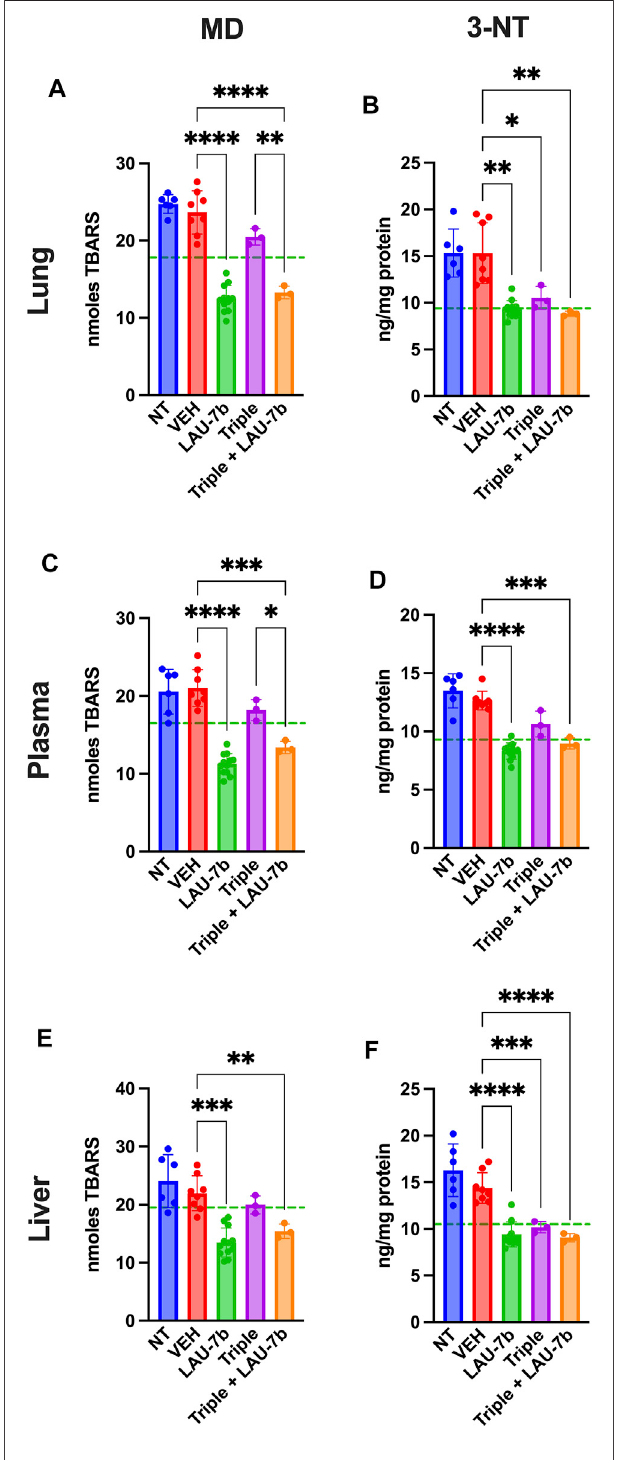
FIGURE 4 | Combination of LAU-7b with Triple therapy restores the imbalances of oxidative stress markers in the lungs, plasma, and liver of F508del/F508del (DD) mice. ELISA analysis of mouse lungs (A,B) , plasma (C,D) and liver (E,F) . Levels for both 3-nitrotyrosine (3-NT) and malondialdehyde (MD) aresigni fi cantlyelevated in Non-treated (NT, n =6)and